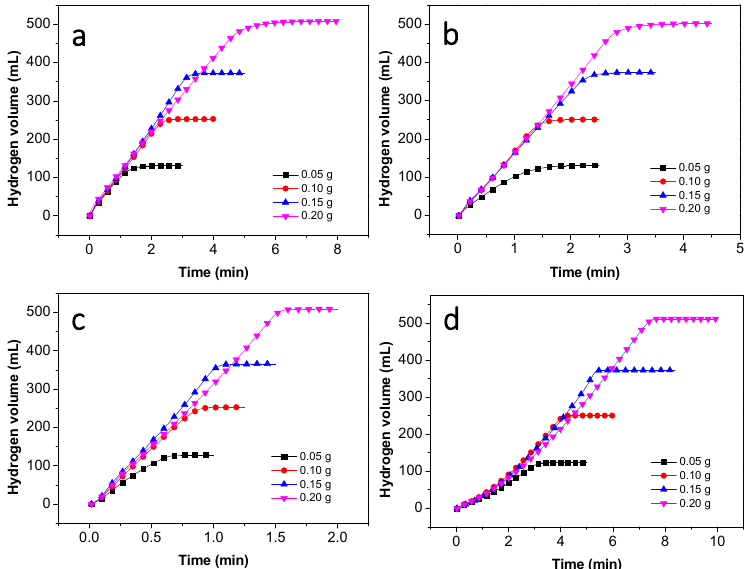
Figure 10. Effect of the NaBH 4 concentration on the HG rate for Co–B catalysts prepared in ( a ) water; ( b ) methanol; ( c ) acetone; and ( d ) acetonitrile. (Batch system; 298 K; 0.05 g catalyst).